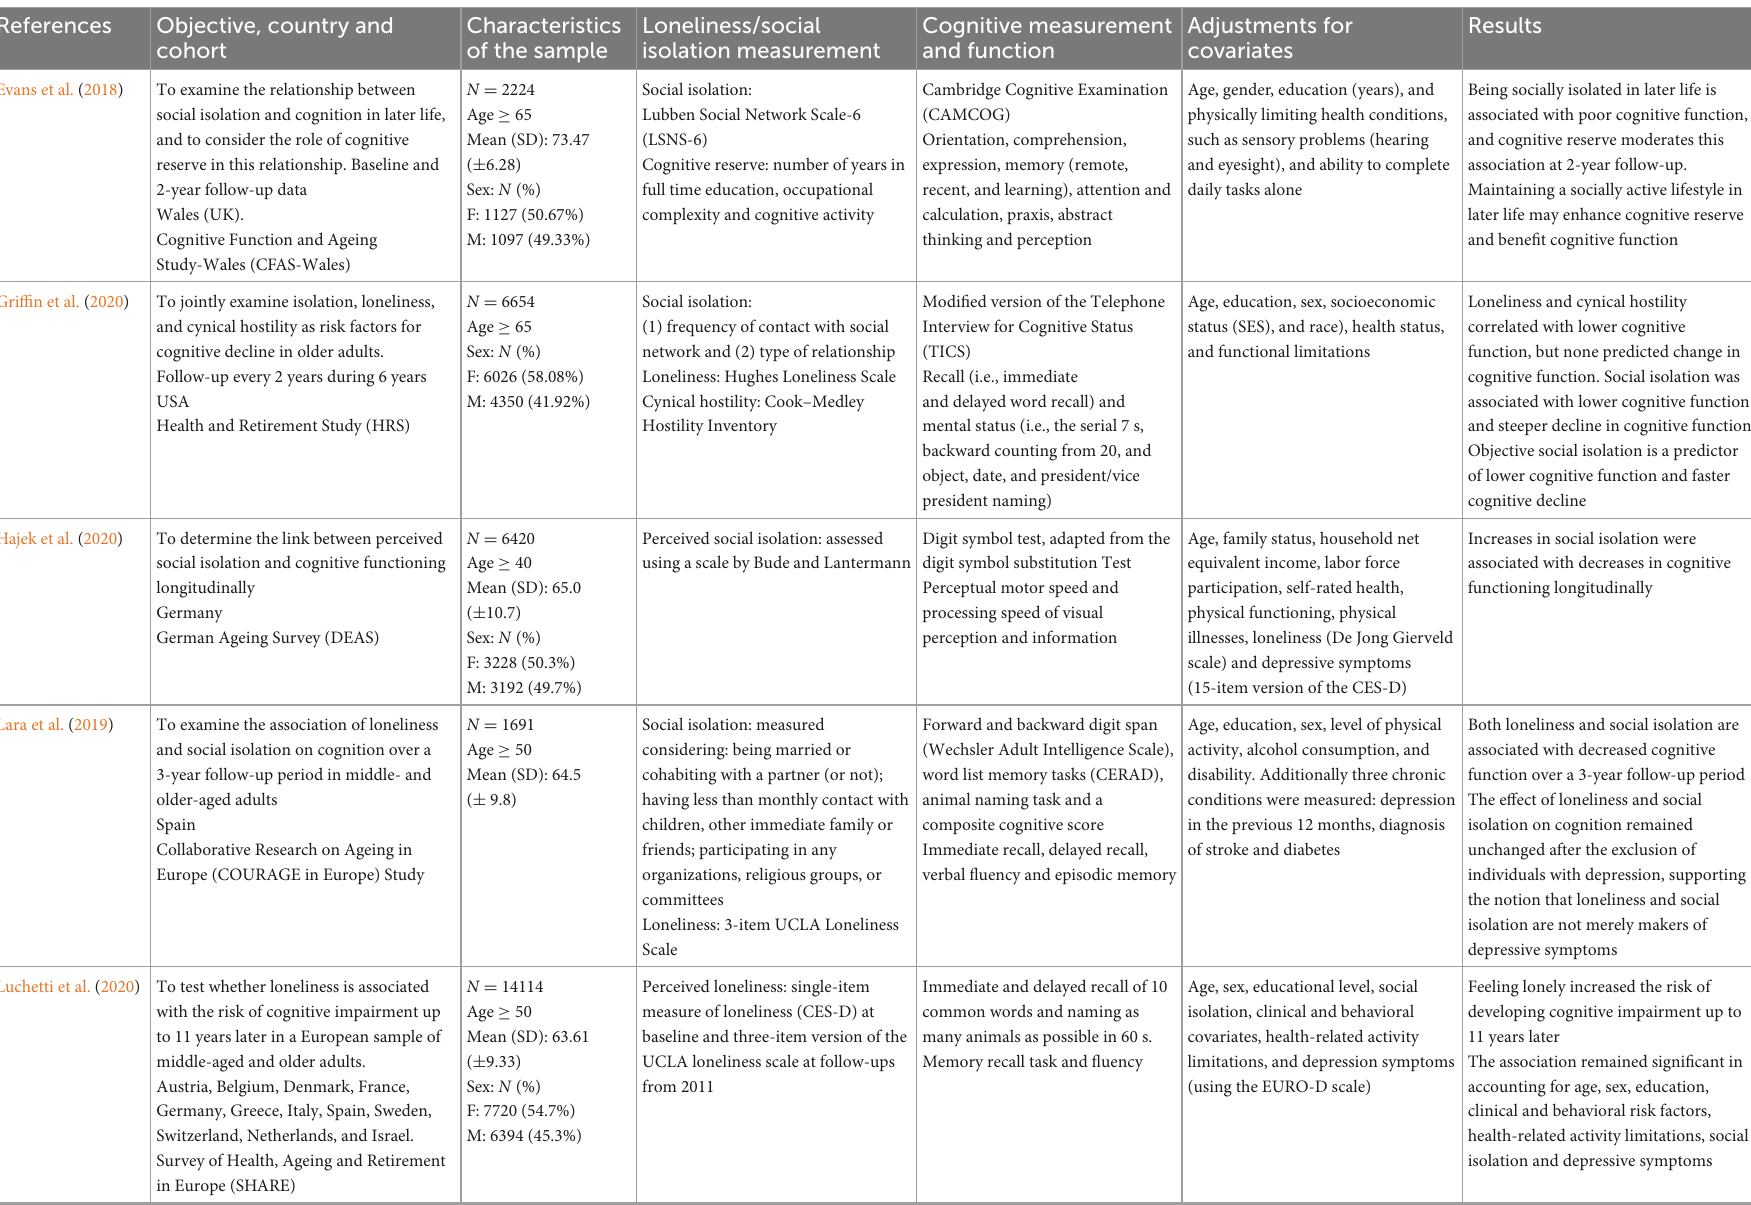
TABLE 1 Relationship between social isolation and/or loneliness and cognitive function in older